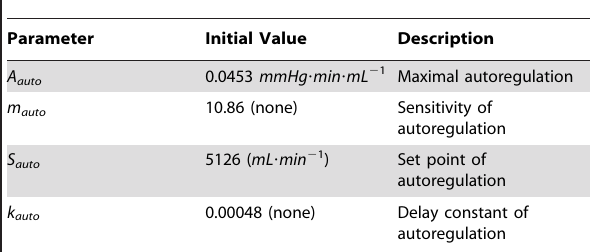
Table 1. Parameters of